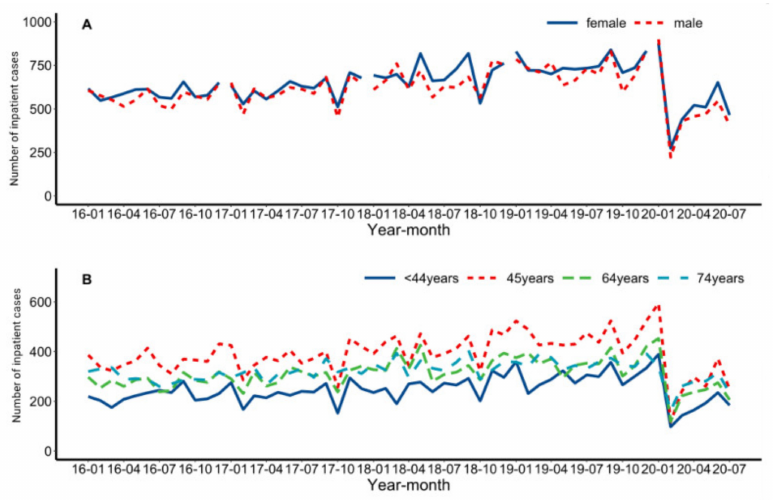
Figure 2. Monthly utilization of healthcare services from January 2016 to July 2020. Legend: Monthly numbers of inpatient visits in men and women ( A ), and in subjects aged ≤ 44, 45–64, 65–74 and ≥ 75 years ( B